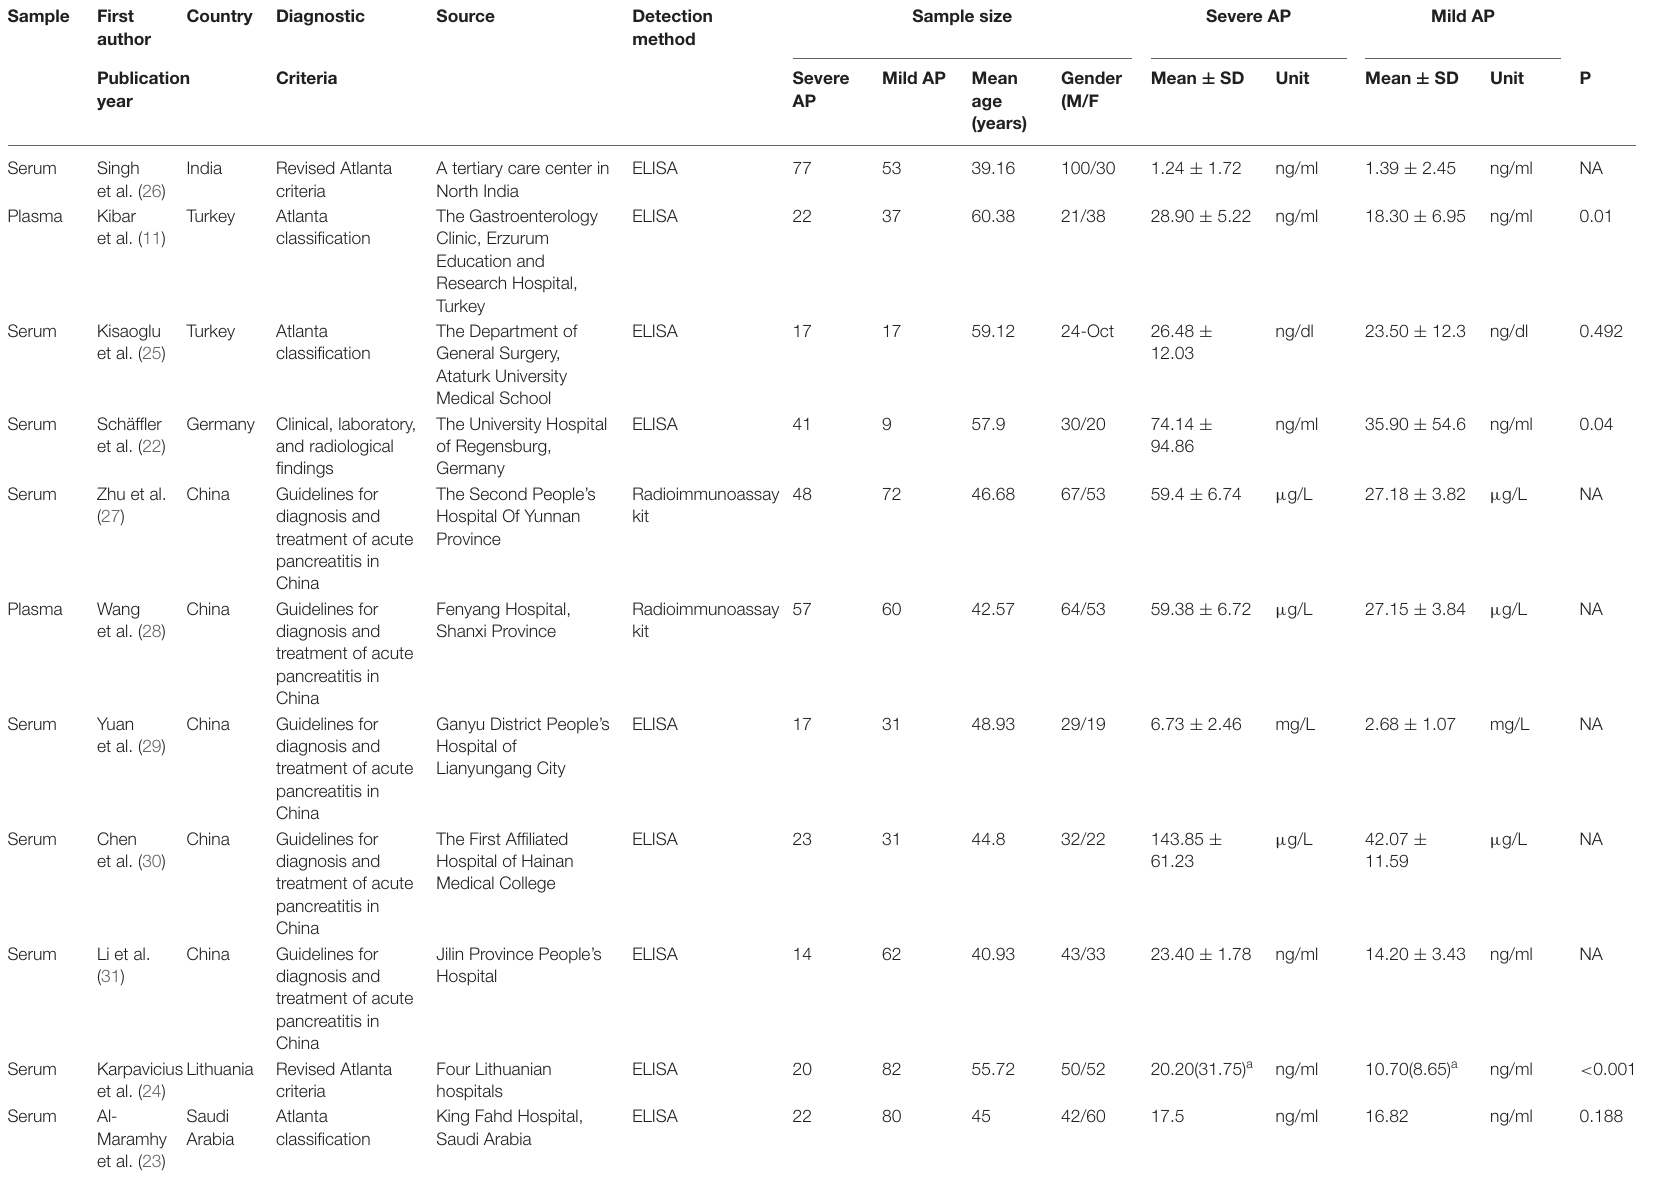
TABLE 1 | Characteristics of the studies included in the